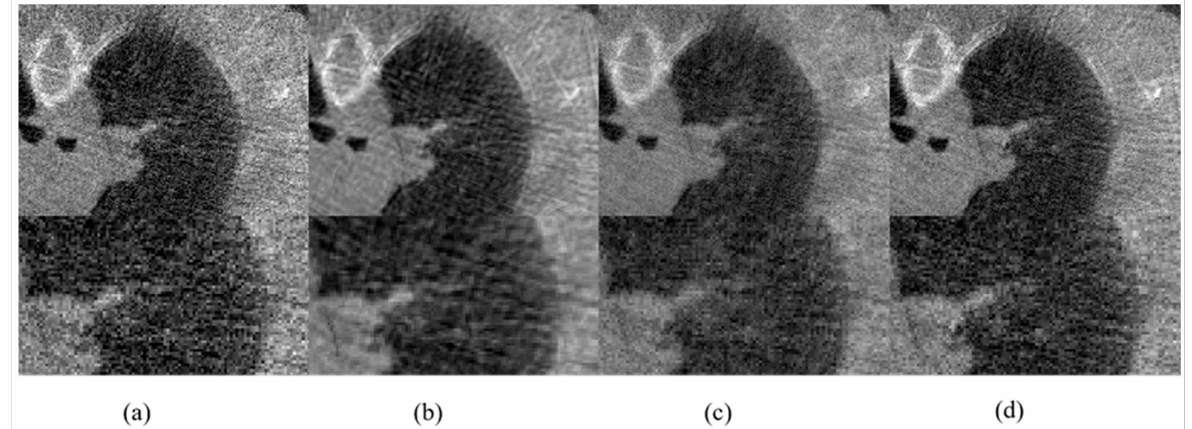
Figure 1. Visual comparison from the SPARE dataset: ( a ) input noisy image, ( b ) resulting image of denoising in the reconstructed image domain, ( c ) resulting image of our proposed method, and ( d ) target